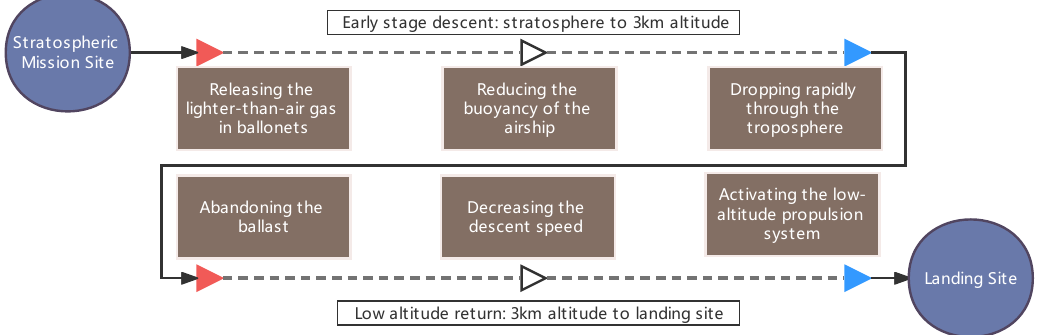
Figure 1. Flow chart of the airship descent